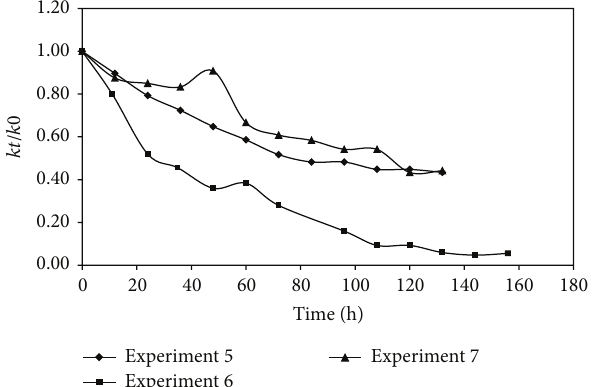
Figure16:Relationshipbetween 𝑘𝑡/𝑘0 andtimeoftheentiretailings column.